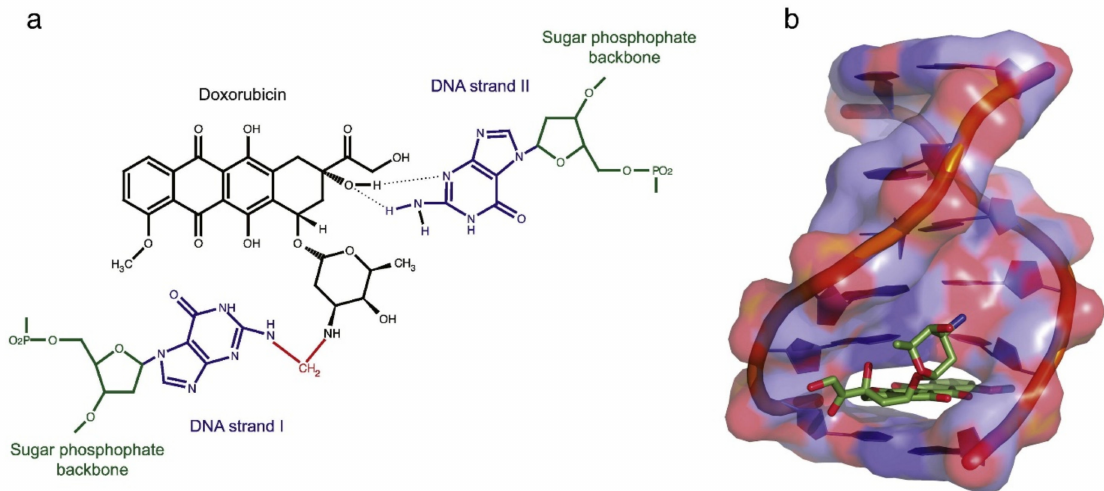
Figure 8. Chemical structure of DOX and mechanisms of action. ( a ) DOX is an anthracycline antibiotic composed of aglycone and an amino-sugar functional group. ( b ) The mechanisms associated to its cytotoxicity can be mainly summarized as: (i) intercalation between DNA base pairs that blocks topoisomerase II activity and prevents DNA replication and RNA transcription, (ii) generation of iron-mediated free radicals that trigger lipid peroxidation and DNA and protein damage. Reproduced from [80]. Copyright ©